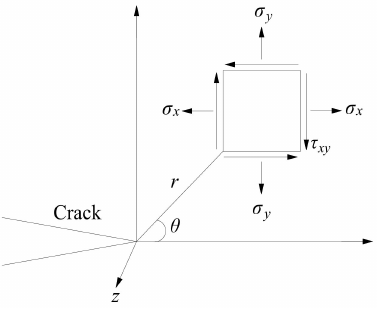
Figure 8. Stress near the crack